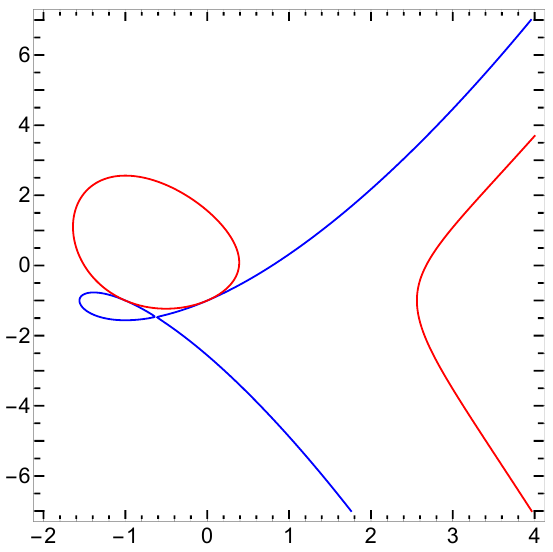
Figure 10 . The elliptic curves E (cid:6) . The curve E + is shown in blue while E (cid:0) is shown in red. Despite appearances, the curve E + is smooth. Over the reals, this curve has two components and there is a gap where, at this scale, the curve appears to have self